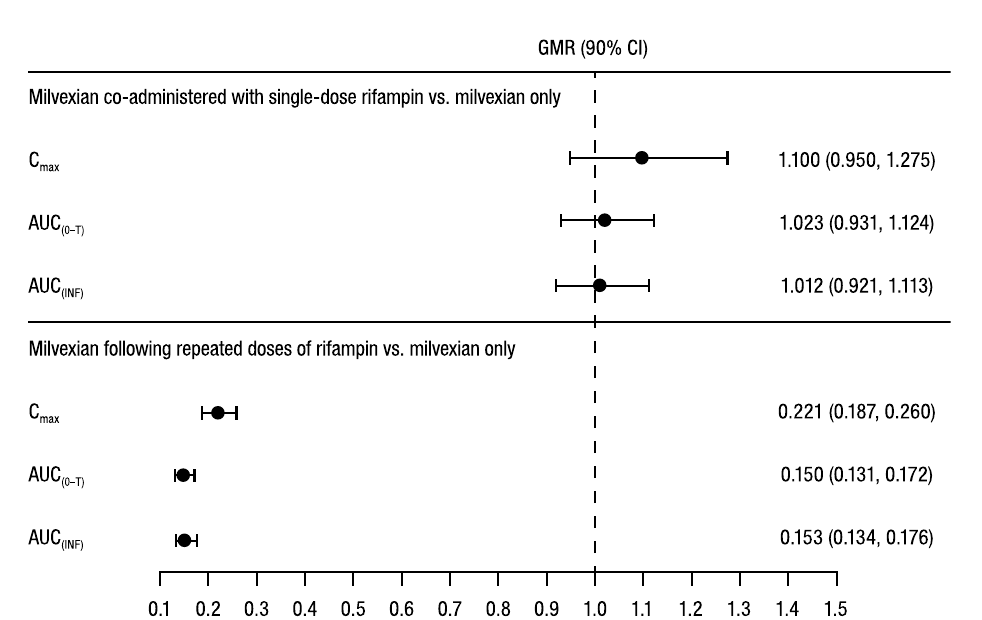
Figure 3. Effect of rifampin on milvexian PK parameters. PK, pharmacokinetic; GMR, geometric mean ratio; CI, confidence interval; C max , maximum observed plasma concentration; AUC (0–T) , area under the plasma concentration–time curve from time 0 to time of last quantifiable concentration; AUC (INF) , area under the concentration–time curve from time 0 extrapolated to infinite